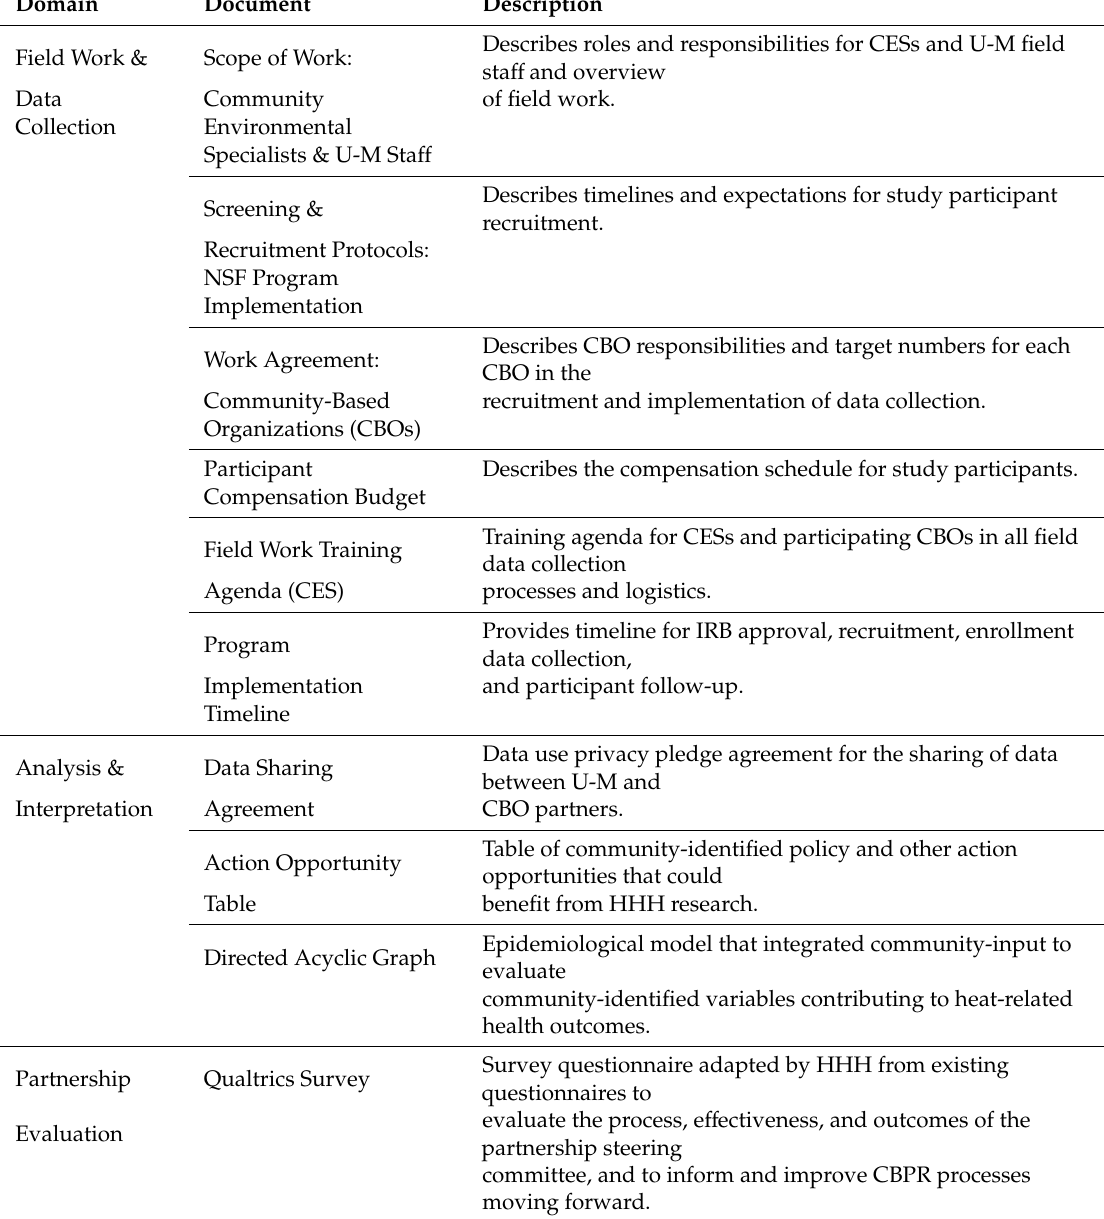
Table of community-identified policy and other action opportunities that could benefit from HHH